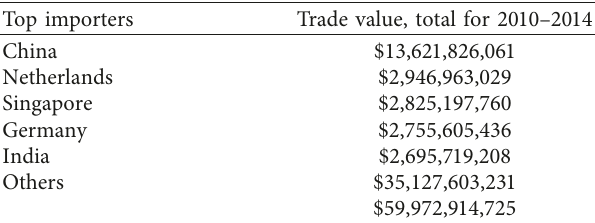
Table 1: Top five global importers of stone, sand, and gravel